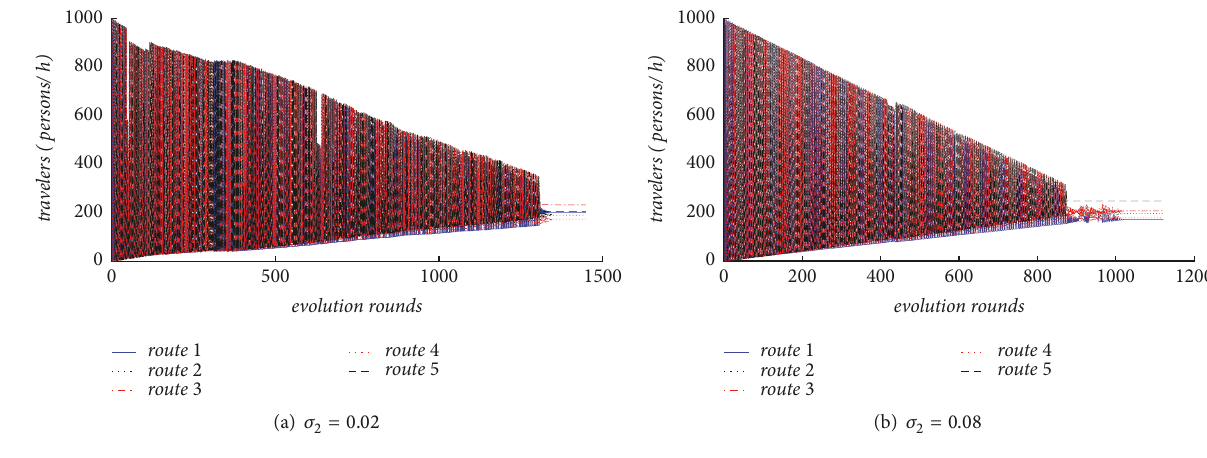
Figure 8: Volume evolution of five routes for 𝑞 = 1000 , 𝛼 = 0.3 , Δ = 0.2 .